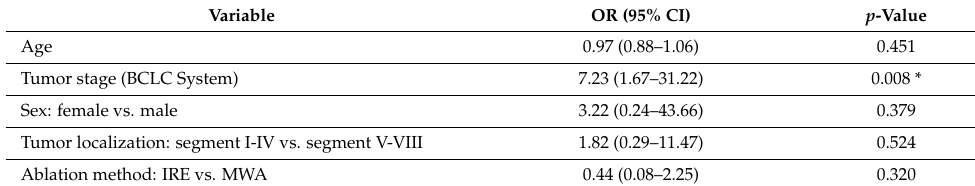
Table 5. Results of binary logistic regression model predicting local tumor